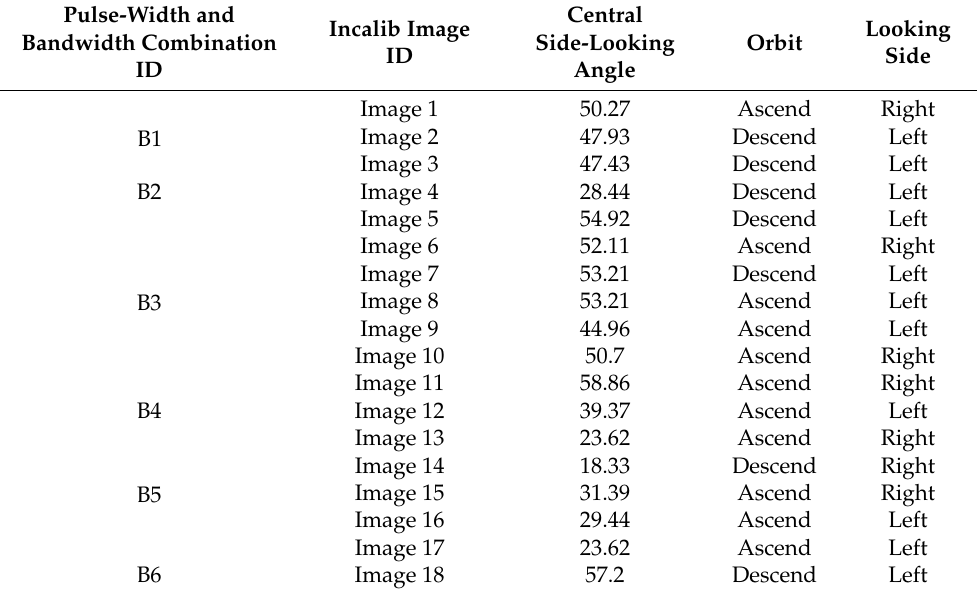
Table 2. Incalib image information.